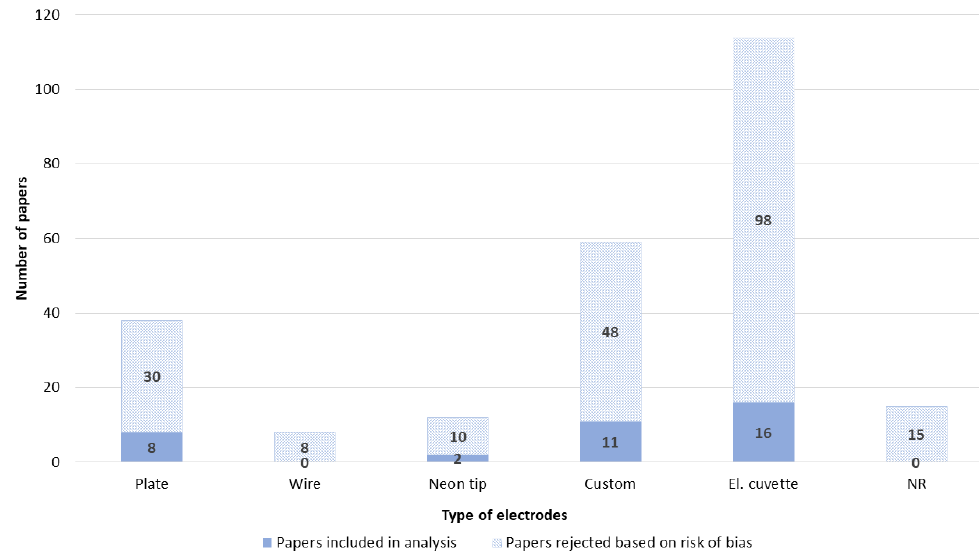
Figure 4. Type of electrodes. NR—not reported.